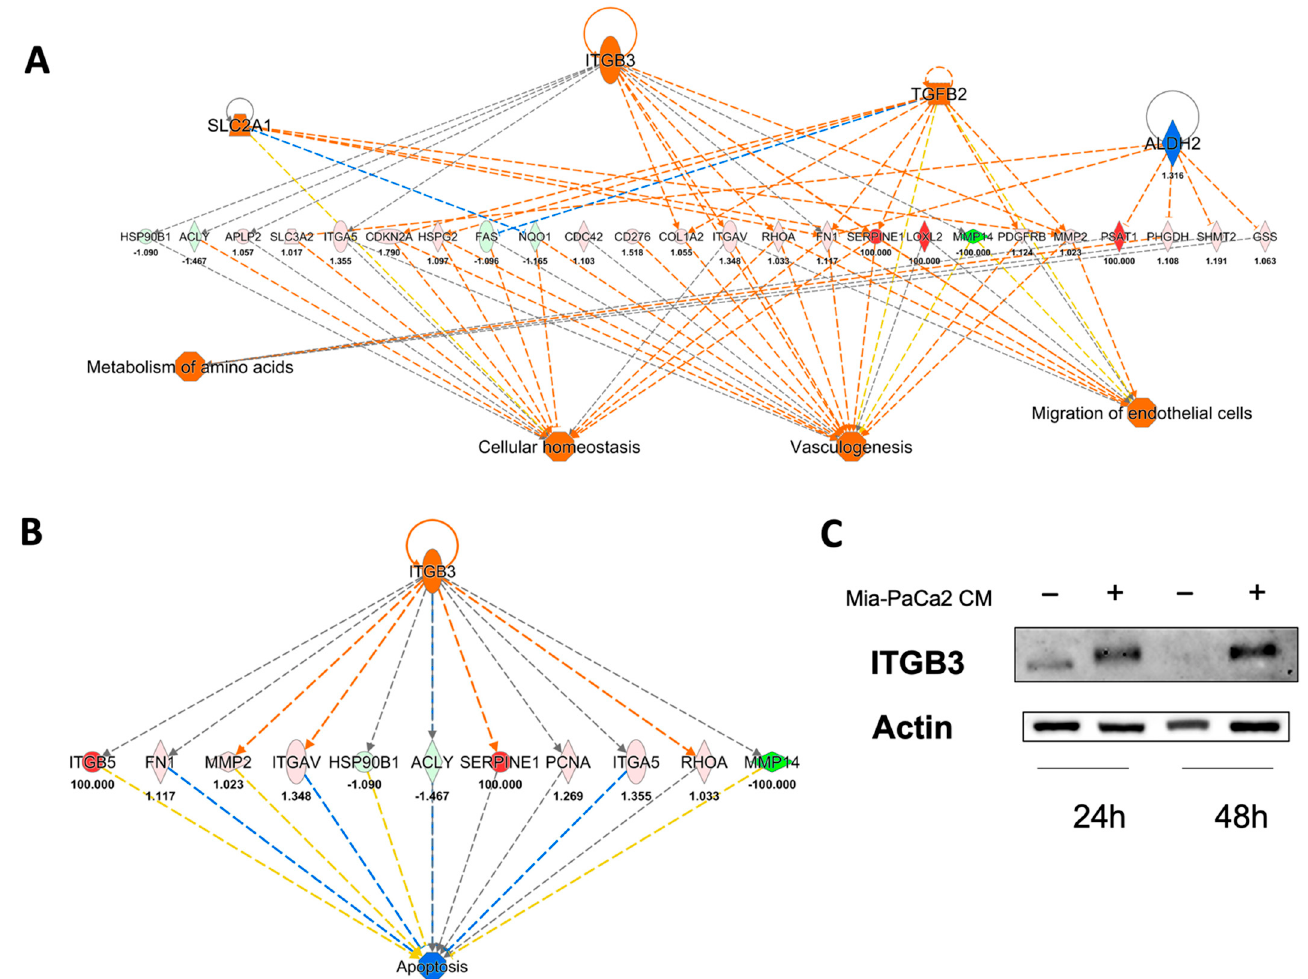
Figure 4. Upstream regulators engaged by 24 h of treatment with MIA-PaCa2 CM . ( A ) Network analysis showing the upstream regulators predicted to be activated (SLC2A1, ITGB3 and TGFB2) and inhibited (ALDH2). The downstream biological effects are also shown. ( B ) Activated ITGB3 is predicted to inhibit apoptosis. Orange node and edges indicate activation, while blue nodes and edges indicate inhibition. Yellow edges reveal an inconsistent relationship between the findings and the state of the downstream node; instead, the gray ones indicate no predicted effects. ( C ) Western blot confirming upregulation of ITGB3.